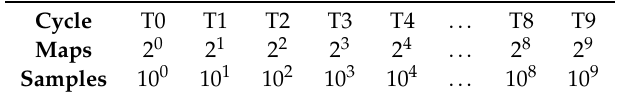
Table 1. Variables growth. The break in the table indicates the linear growth of the exponent. Cycle T0 T1 T2 T3 T4 ... T8 T9 Maps 2 0 2 1 2 2 2 3 2 4 ... 2 8 2 9 Samples 10 0 10 1 10 2 10 4